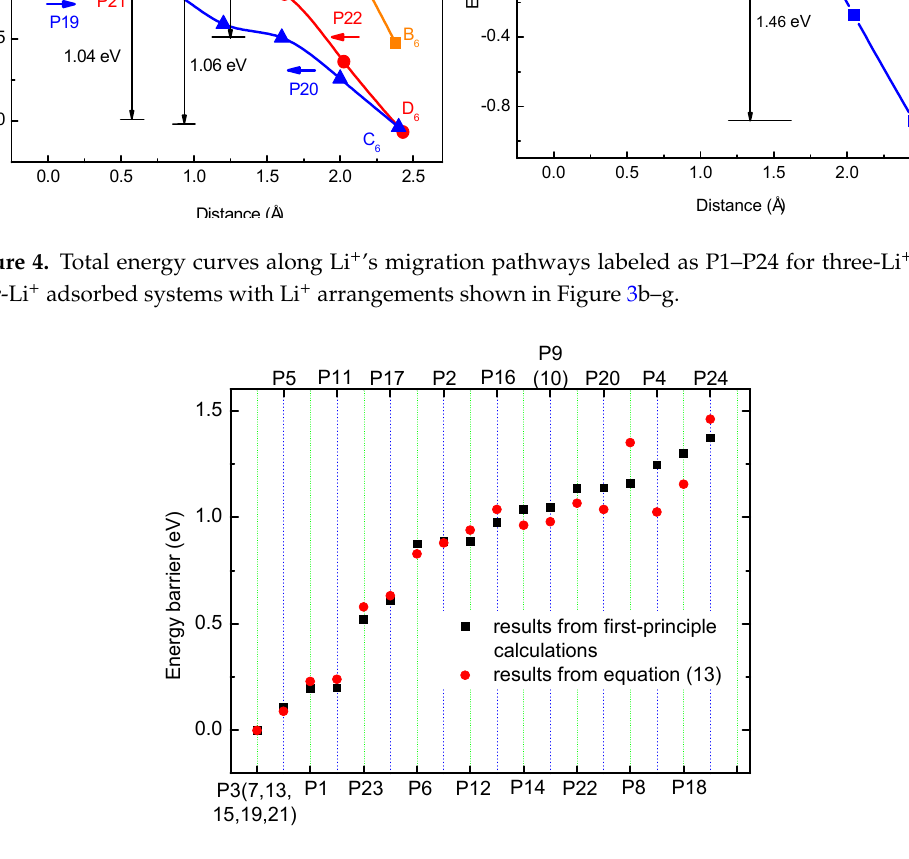
Figure 5. The energy barriers obtained from first-principle calculations and from Equation (13) for various Li + ’s migration paths P1–P24 shown in Figure 4a–f.